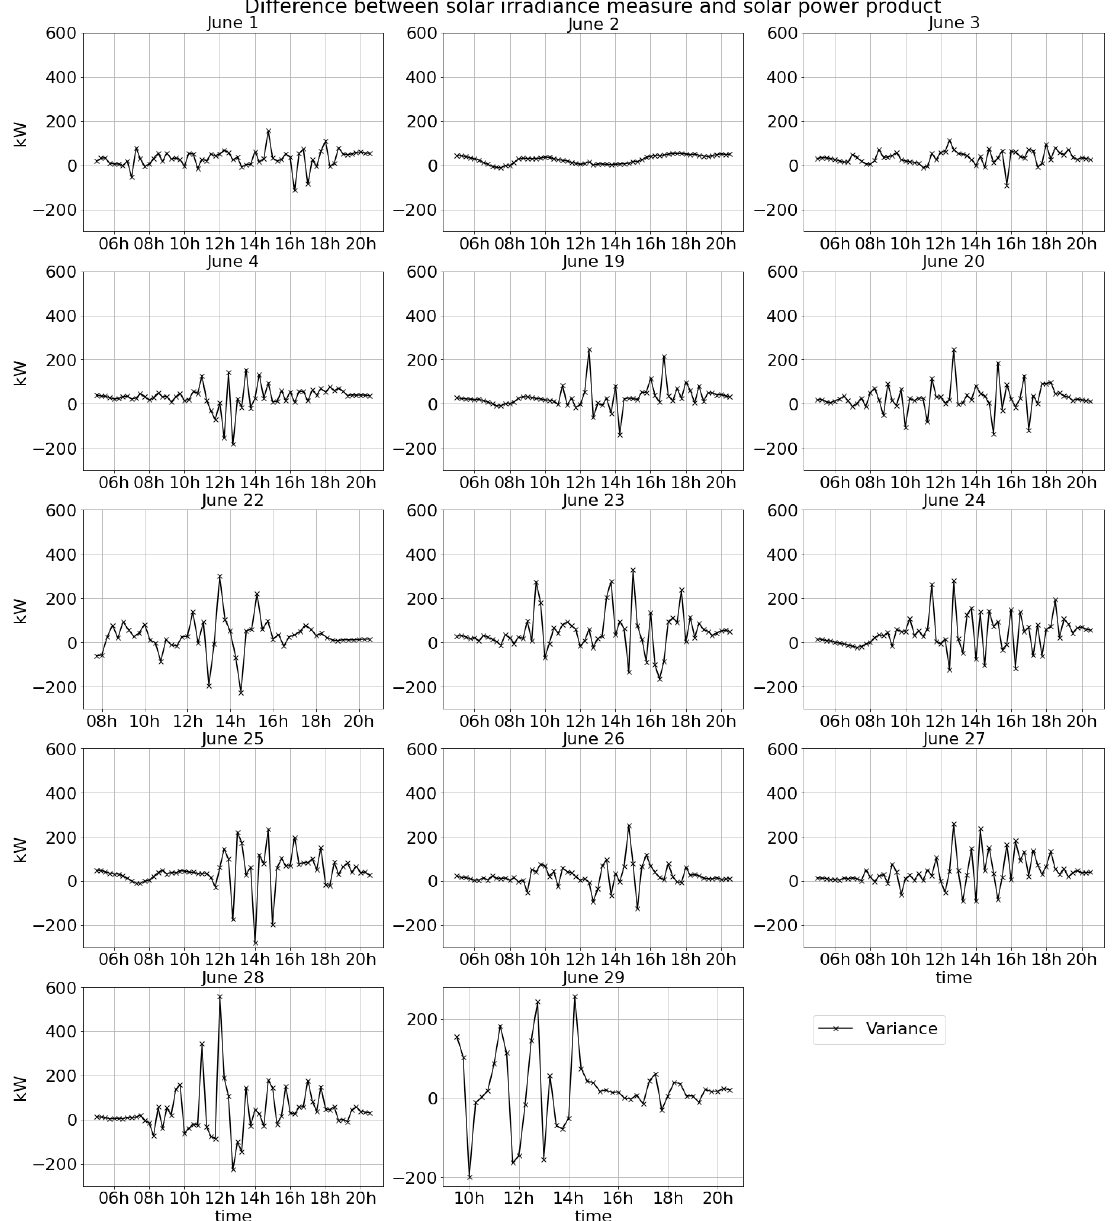
Figure A11. Difference between solar irradiance and solar power product when the solar power product is projected to the solar irradiance measure for 14